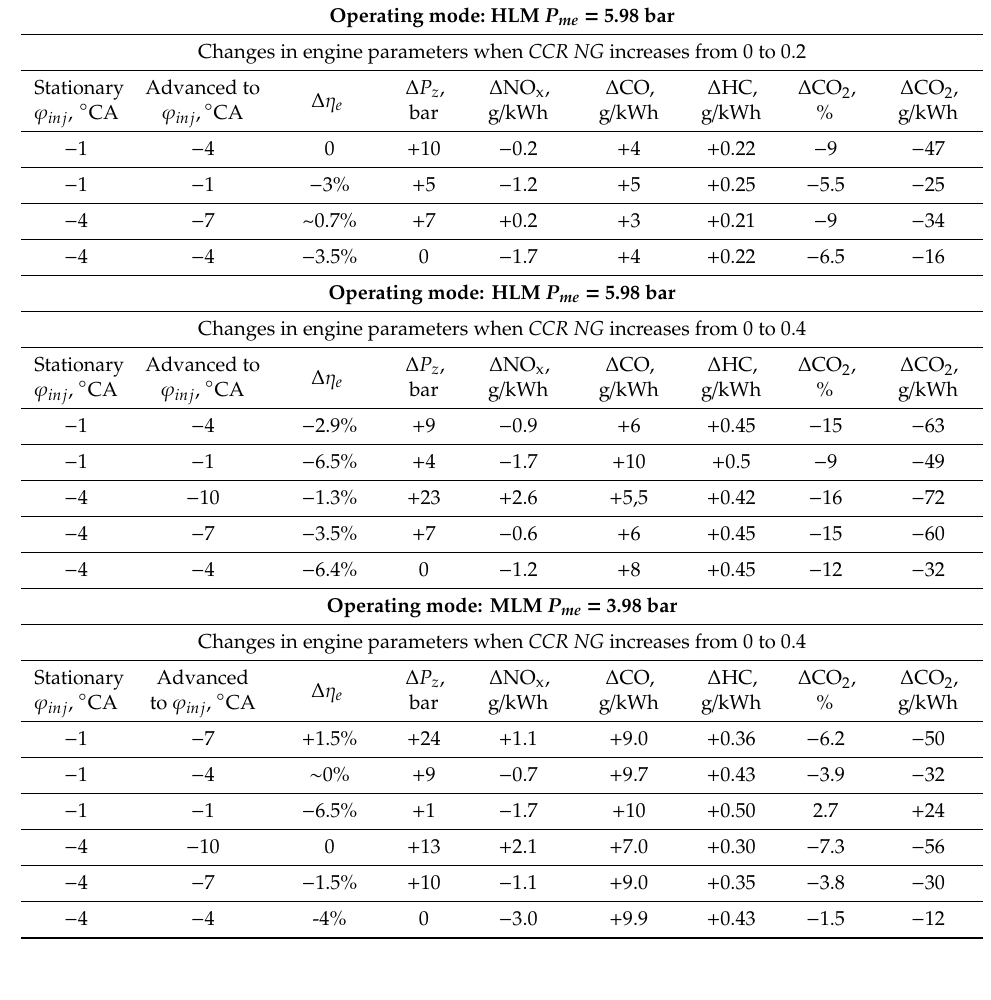
Figure 9. Influence of dual-fuel CCR NG portion and ϕ inj on CO 2 emissions ( n = 2000 min (cid:2879)(cid:2869) ) : ( a ) HLM; ( b ) MLM; ( c ) LLM. The dots in the graph represent the experimental data. Table 8. Influence of investigated engine (79.5 / 95.5) conversion to operation with NG fuel feed on energy e ffi ciency and emission